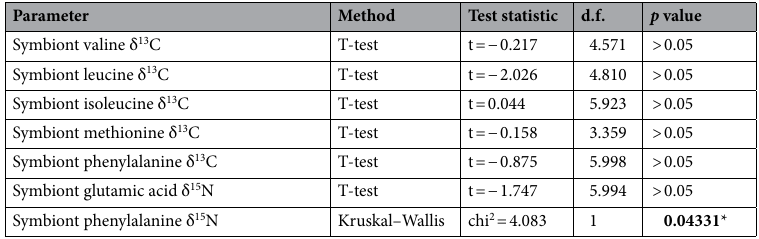
Table 1. Results of statistical analyses comparing characteristics of Oculina patagonica coral colonies originating from shallow vs. deep collection sites. Comparisons are considered statistically significant where p ≤ 0.05 and are displayed in bold type. Asterisks indicate the level of significance *p < 0.05, **p < 0.01, ***p < 0.005. Degrees of freedom (d.f.).